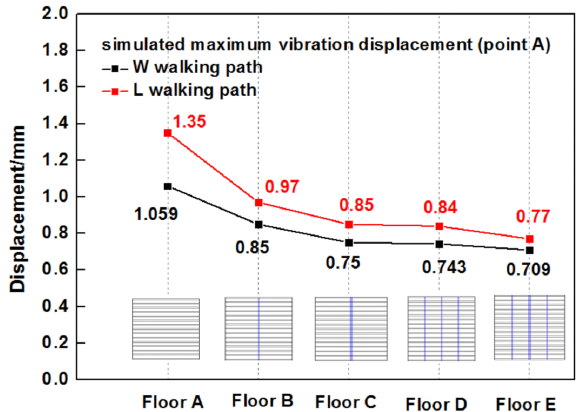
Figure 24. Simulated peak displacement at points A for the floors.